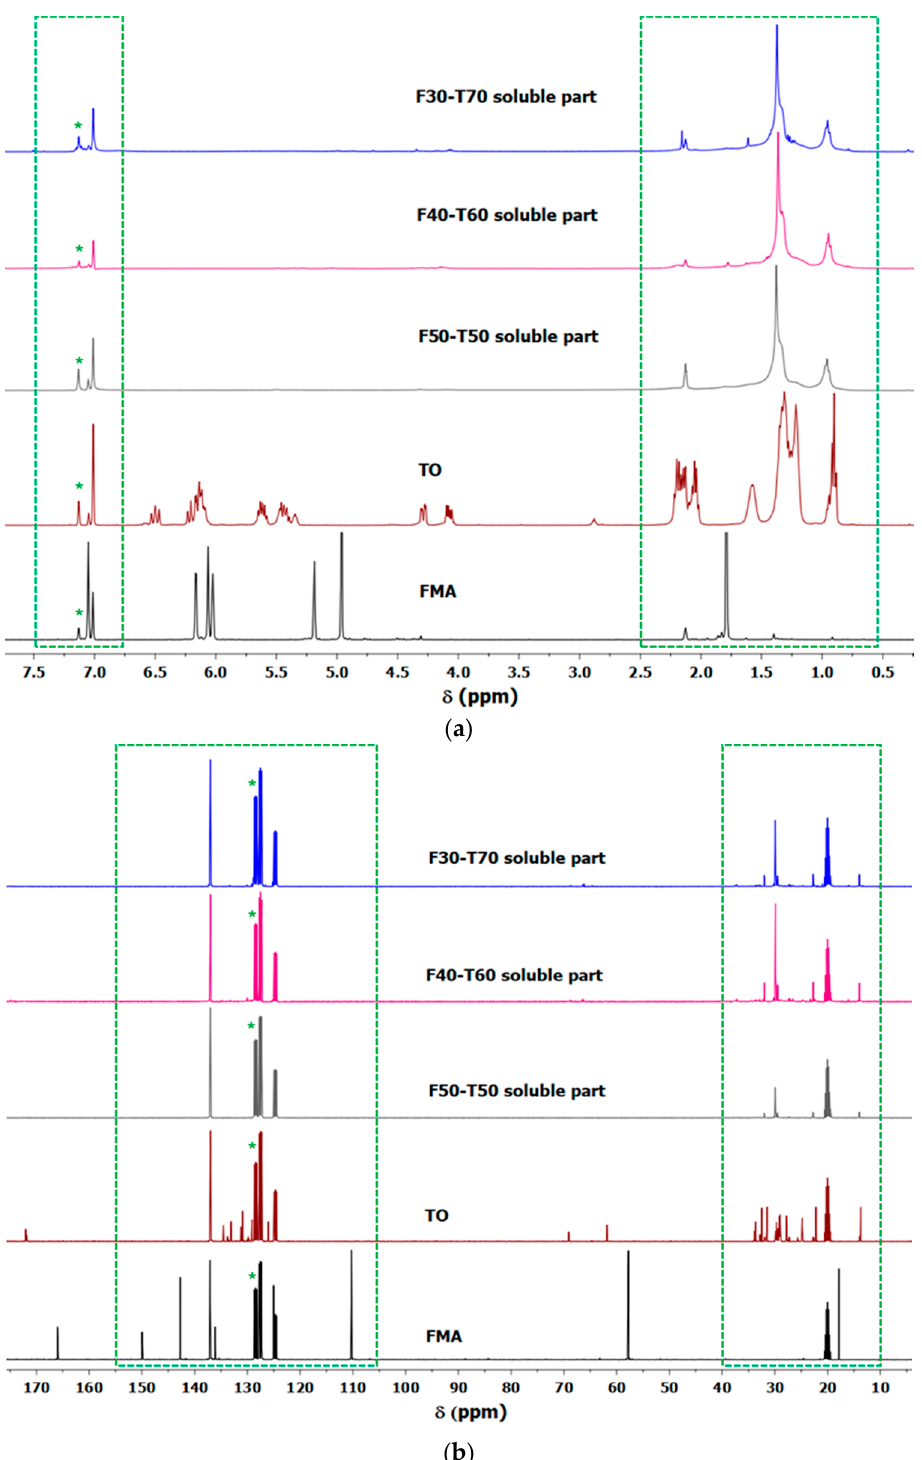
Figure 10. ( a ) 1 H NMR (nuclear magnetic resonance) signals of Soxhlet extracted portions from FMA-TO polymers (green square shape indicates the differences in signals among the samples in the region δ 0.5–2.5 ppm and δ 6.7–7.5 ppm; * indicates the solvent peak). ( b ) 13 C NMR signals of Soxhlet extracted portions from FMA-TO polymers (green square shapes indicate the differences in signals among the samples in the region δ 10–40 ppm and δ 105–155 ppm; * indicates the solvent peak). While TO content increased in the system, a specific proportion of TO took part in cross-linking reactions and the rest contributed to the formation of soluble fragments. As a result, TO-related